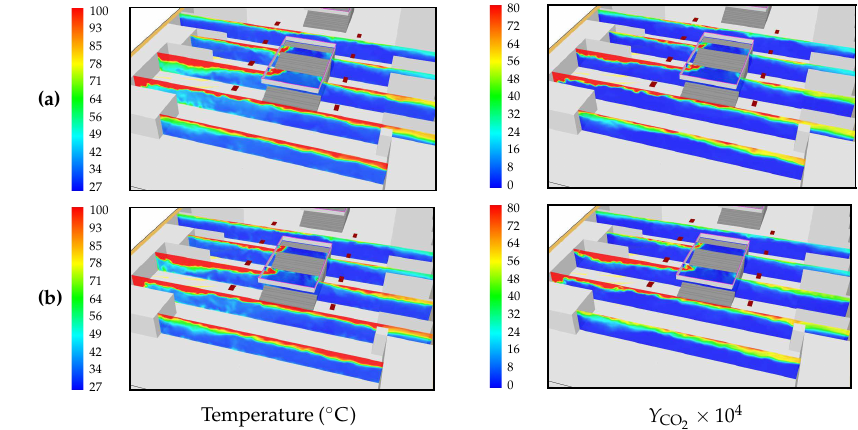
Figure 7. Heat release rate (HRR) in the simulations of cases G-1 to G-4 (Table 1), compared with that of the EDC combustion model.